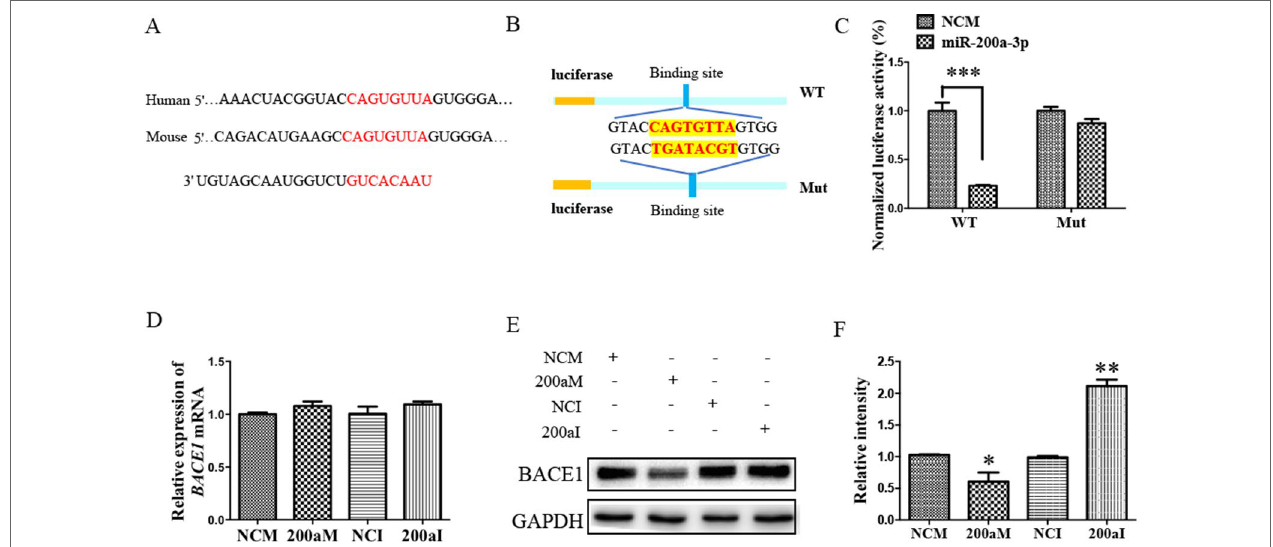
FIGURE 3 | The BACE1 mRNA is a direct target of miR-200a-3p. (A) Bioinformatic analysis predicting the binding site of miR-200a-3p and BACE1 mRNA. (B) Design of the recombinant Luc- BACE1 -MUT (mutant) and Luc- BACE1 -WT (wild-type) construction. (C) Changes in the relative luciferase activity in each group after plasmids transfection. miRNA-200a-3p mimics caused significant inhibition of reporter luciferase activity in the construct with a wild-type (WT) BACE1 3’-UTR in contrast to the mutant (Mut) BACE1 3’-UTR in HEK293 cells ( n = 4). (D) Quantification analysis of the levels of BACE1 mRNA after transfection with miRNA- 200a-3p mimics (200aM), miRNA-200a-3p inhibitors (200aI), and corresponding negative controls (NCM/NCI) ( n = 3). (E , F) The expression of the BACE1 protein is significantly decreased and increased after miR-200a-3p mimics (200aM) and inhibitor (200aI) transfection, respectively, relative to the corresponding negative controls (NCM/NCI), as demonstrated here by representative images (E) and quantitative analysis (F) by Western blotting ( n = 3). The data are presented as the mean ± SEM. * P < 0.05, ** P < 0.01, *** P < 0.001 versus relevant